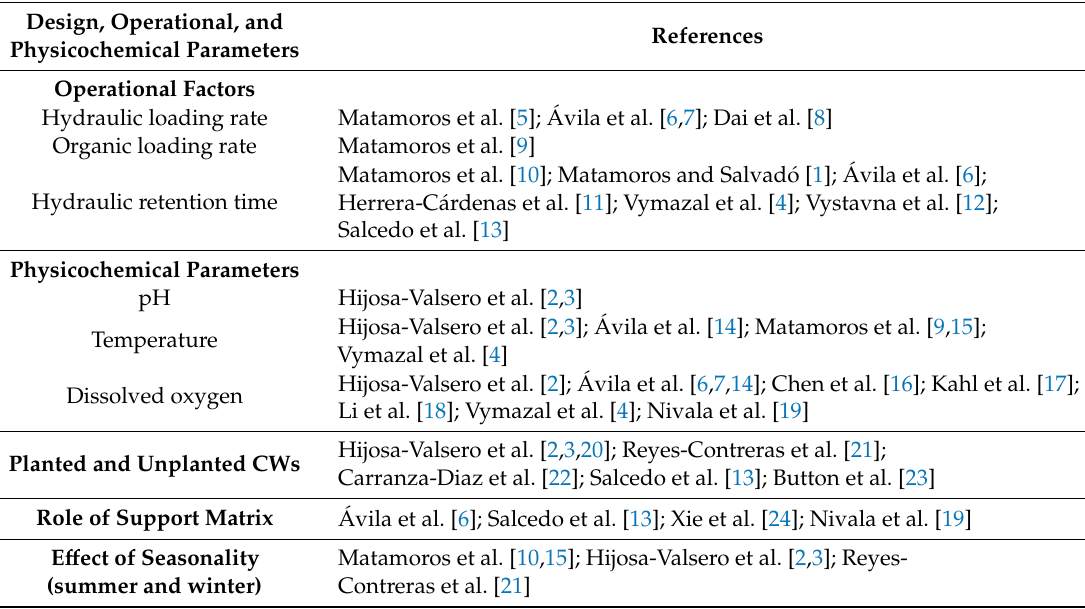
Table 1. The design, operational, and physicochemical parameters of studied constructed wetlands (CWs) and corresponding